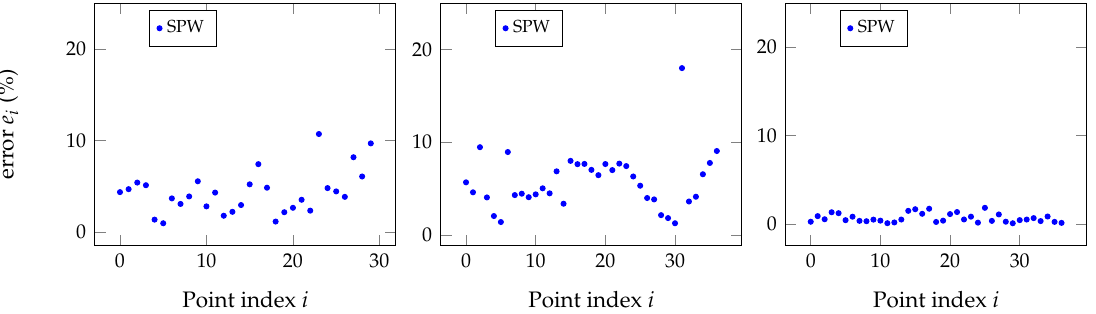
Figure 16. RMS errors for the three sensors relative to the reference sensor for the point clouds whose results are shown in Figure 15 but with additional points removed by observing the MPW versus the SPW results. The observable conclusion when comparing to previous figures is that additional outliers have been removed even after the application of the Chauvenet